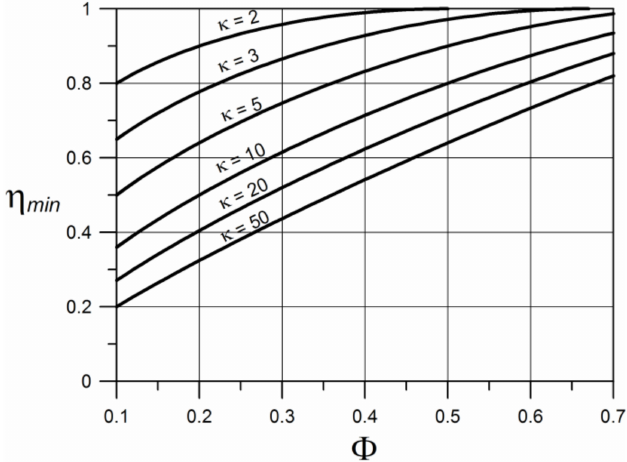
Figure 13. Dependence of economic coefficient for the optimal location of ATI layer on the dimen- sionless temperature and pricing